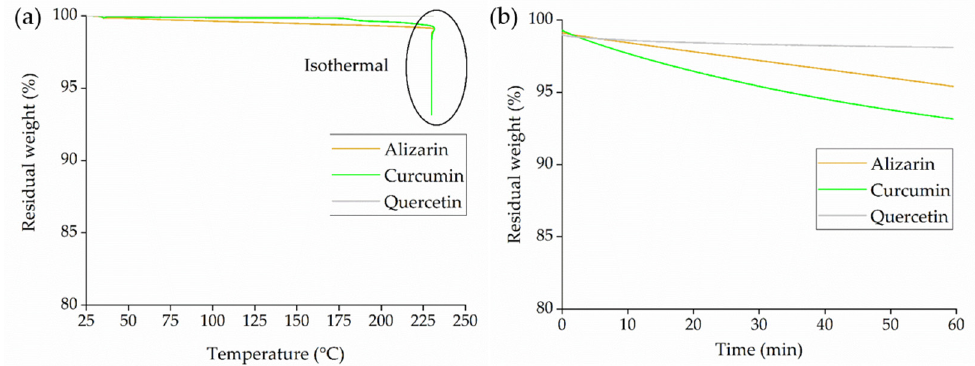
Figure 5. TGA thermogram of dyes during ( a ) the heating ramp to 230 °C and ( b ) the isothermal step at 230 °C for 60 min.